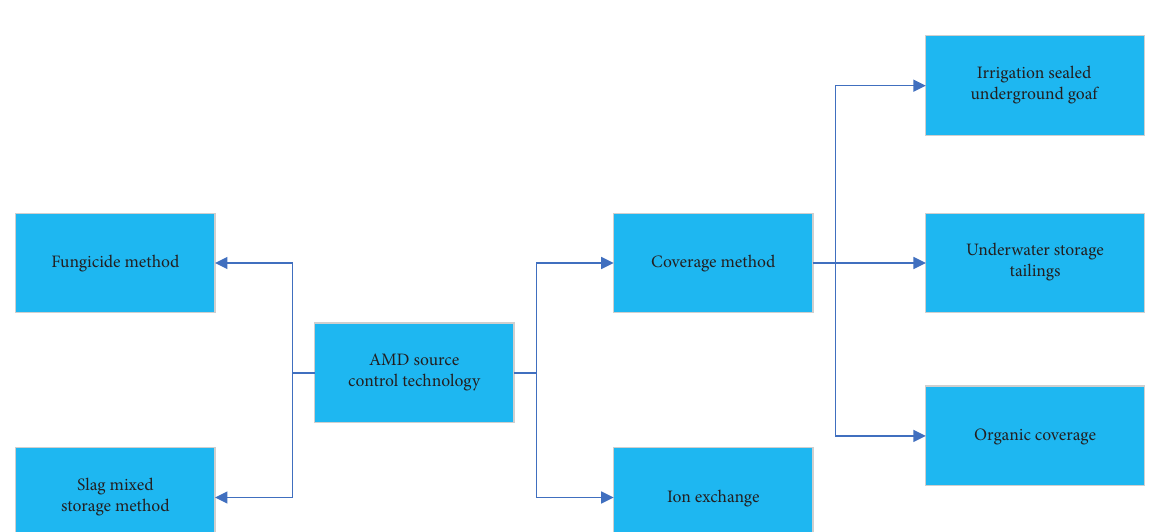
Figure 7: AMD source control